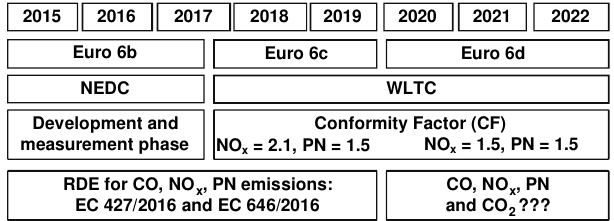
Fig. 3. The share of urban, rural and motorway sections in test routes